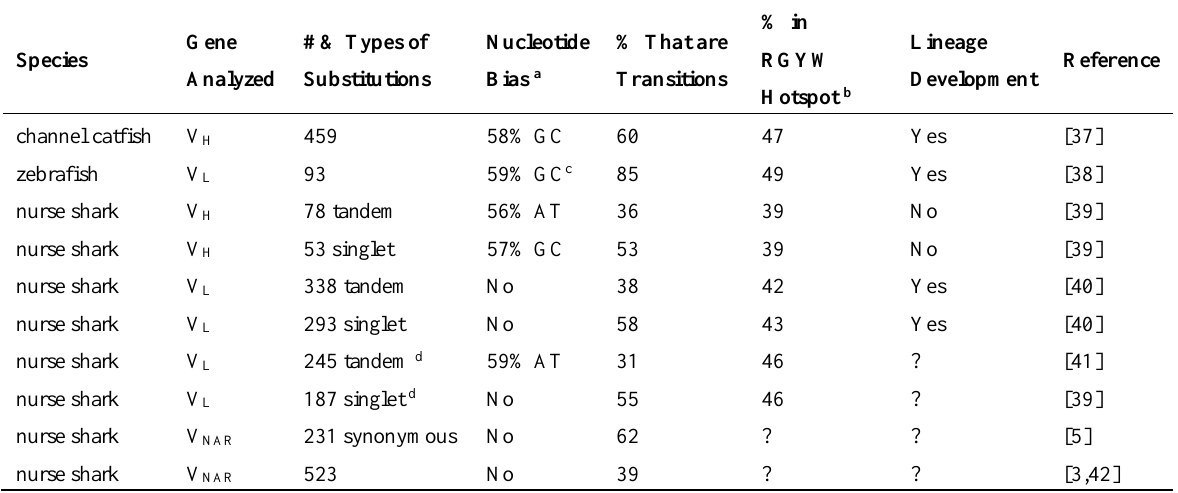
Table 1. The nature and spectrum of somatic mutations in cartilaginous and bony